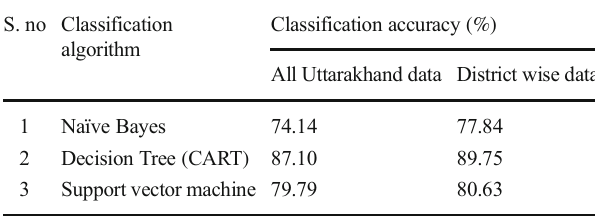
Prediction accuracy of different classifiers S. no Classification